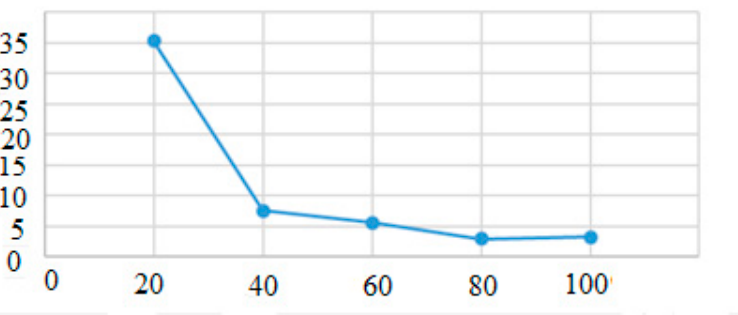
Figure 20. Error number as a function of training cycle number.